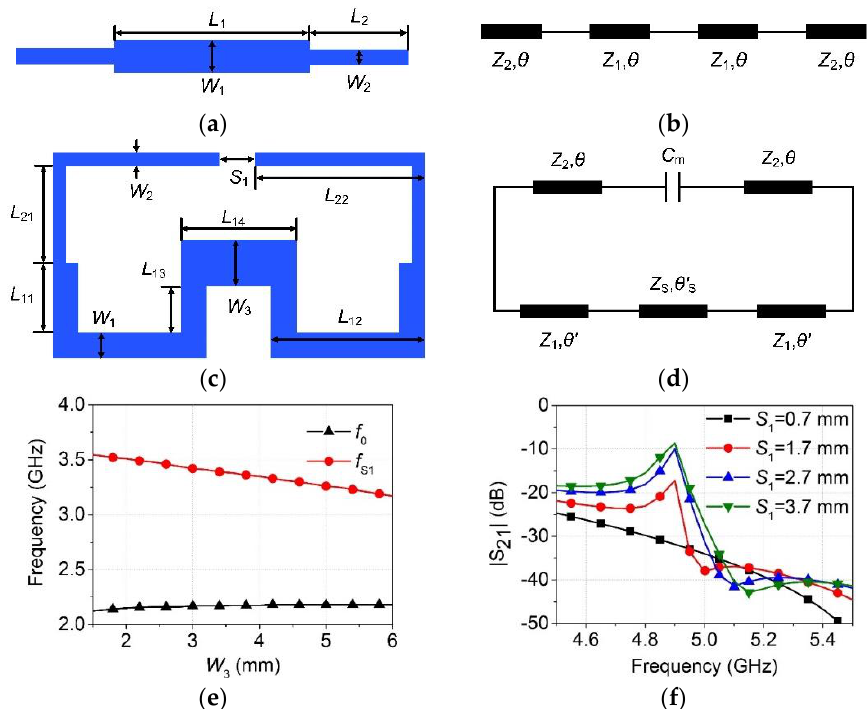
Figure 1. Design of folded open-loop stepped-impedance resonators (FOLSIR). ( a ) Schematic diagram of stepped-impedance resonators (SIR); ( b ) The equivalent circuit diagram of the SIR; ( c ) Schematic diagram of FOLSIR; ( d ) The equivalent circuit diagram of the FOLSIR; ( e ) The simulated resonant frequency f 0 and f S 1 of the FOLSIR for various values of W 3 ; ( f ) The simulated | S 21 | response of the resonator for various values of S 1